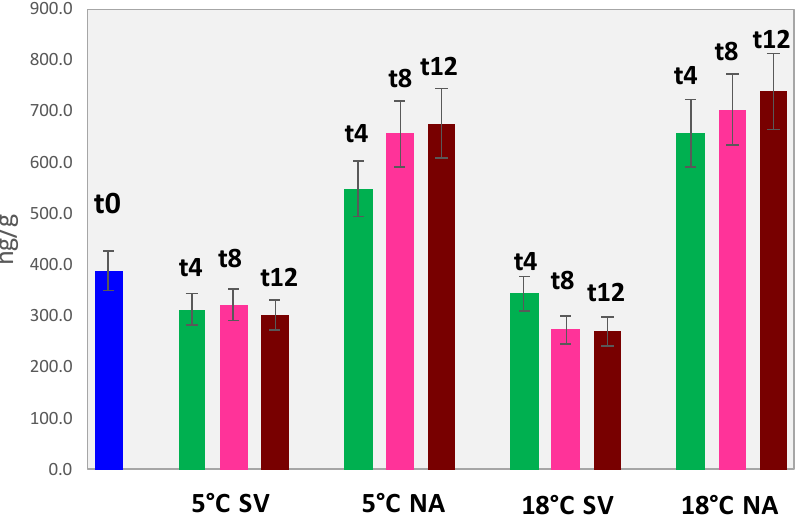
Figure 5. Histogram reporting hexanal equivalents (ng/g) for walnut samples analyzed at the different shelf-life time points and storage